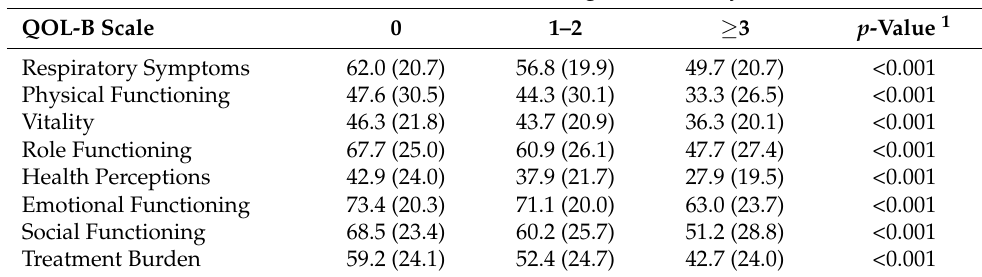
Table 3. Discrimination of QOL-B scores, stratified by history of pulmonary exacerbations in the previous 12 months (categorized).